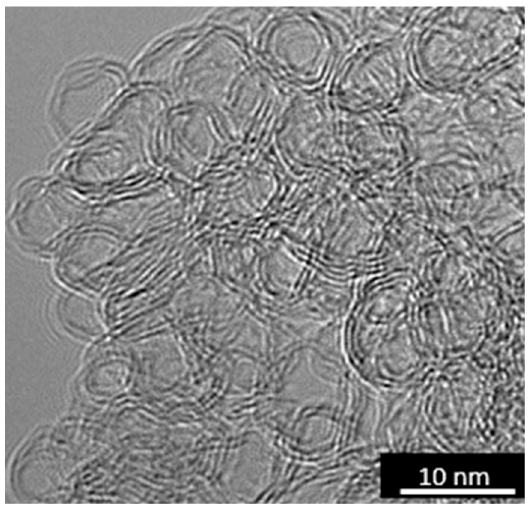
Figure 14. TEM micrograph of sucrose char after 5 s at 2600 °C.